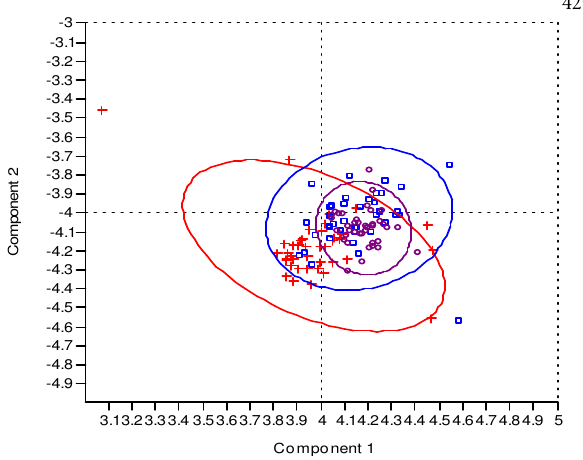
Fig. 3. Principal components analysis based on 25 morphometric measurements of T. zillii showing overlap of characters between populations from Opa Reservoir (red), Igun Reservoir (purple) and Osu Reservoir (blue)